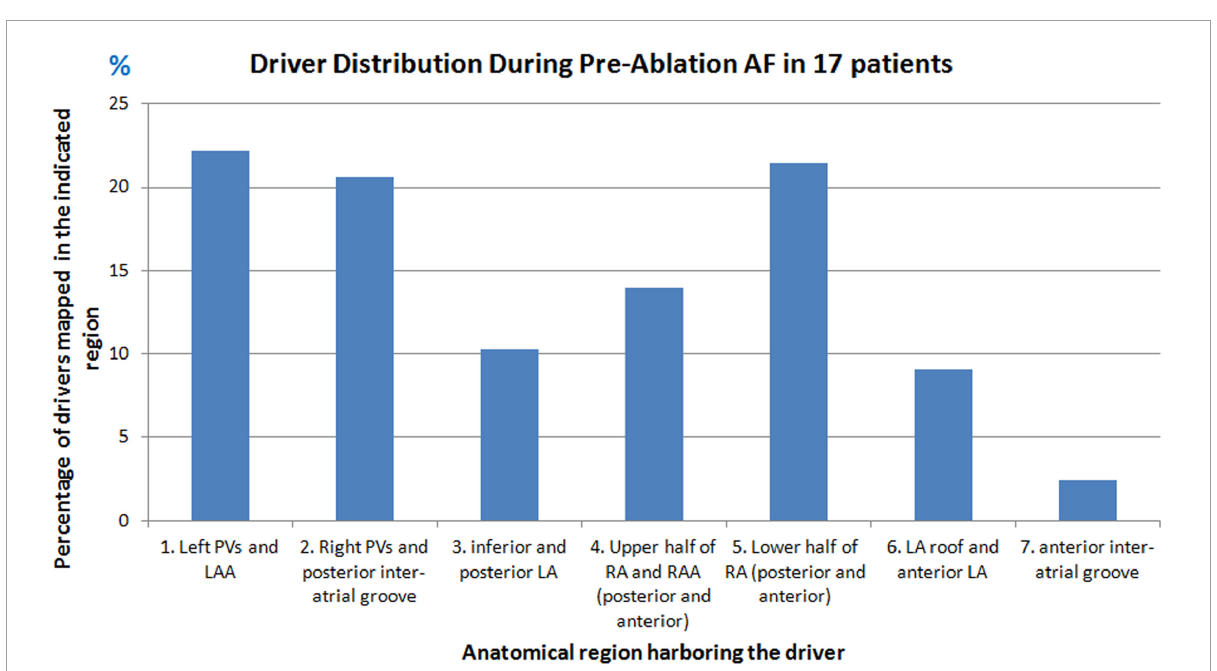
FIGURE1 Driver distribution during pre-ablation persistent AF. Graph shows the percentage of drivers mapped from different anatomical regions of the atria in seventeen patients during pre-ablation persistent